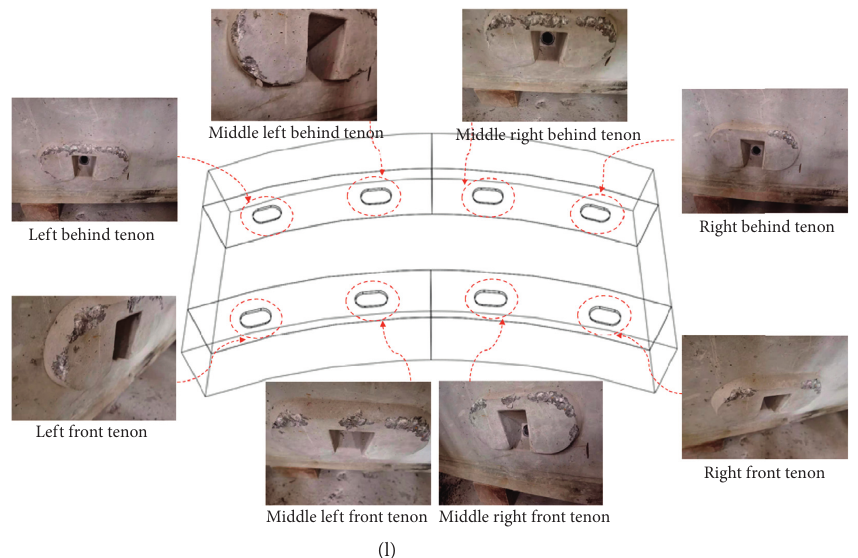
Figure 14: Final broken shape of the intermediate ring segment: (a) damaged in left inner corner, (b) local failure of longitudinal joints, (c) failure of the right inner corner, (d) bolt hole crack, (e) longitudinal crack, (f) cracks around the grouting hole, (g) partial failure of the left lateral longitudinal joint, (h) outside the vault collapsed, (i) local failure of the outer longitudinal joint on the right, (j) schematic diagram of the internal crack, (k) schematic diagram of cracks in thickness direction, and (l) the damage of mortises and